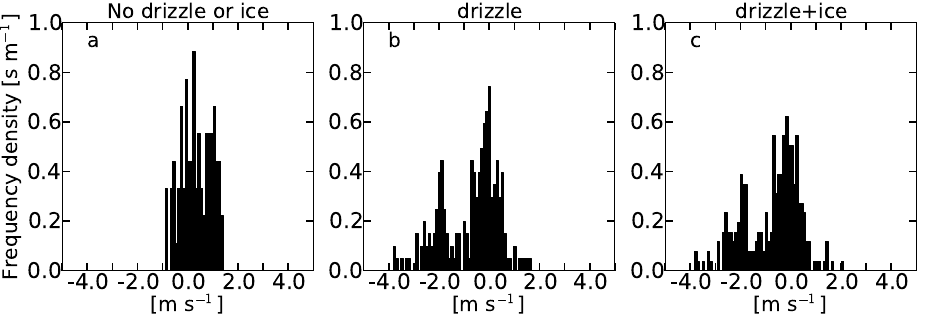
Fig. 2. Observed vertical velocity distributions at cloud base for 6 June 2008 at Lindenberg demonstrating a bias caused by fall speed of large particles. (a) : liquid cloud droplets only, (b) : drizzle included, (c) : ice particles and drizzle included. Velocity is positive upwards.